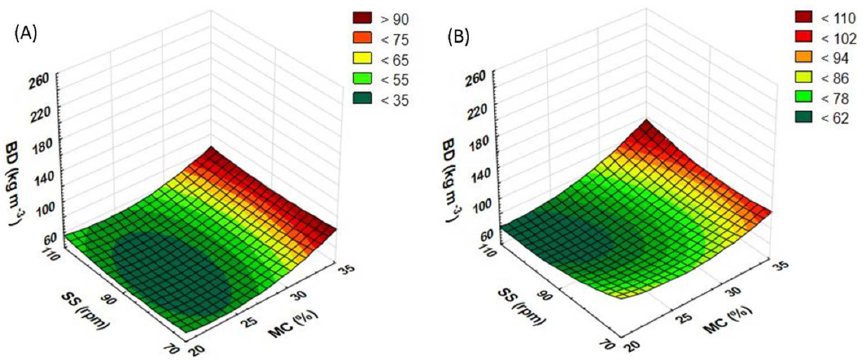
Figure 13. The result of BD measurement for extruded rapeseed straw ( A ) and buckwheat straw ( B